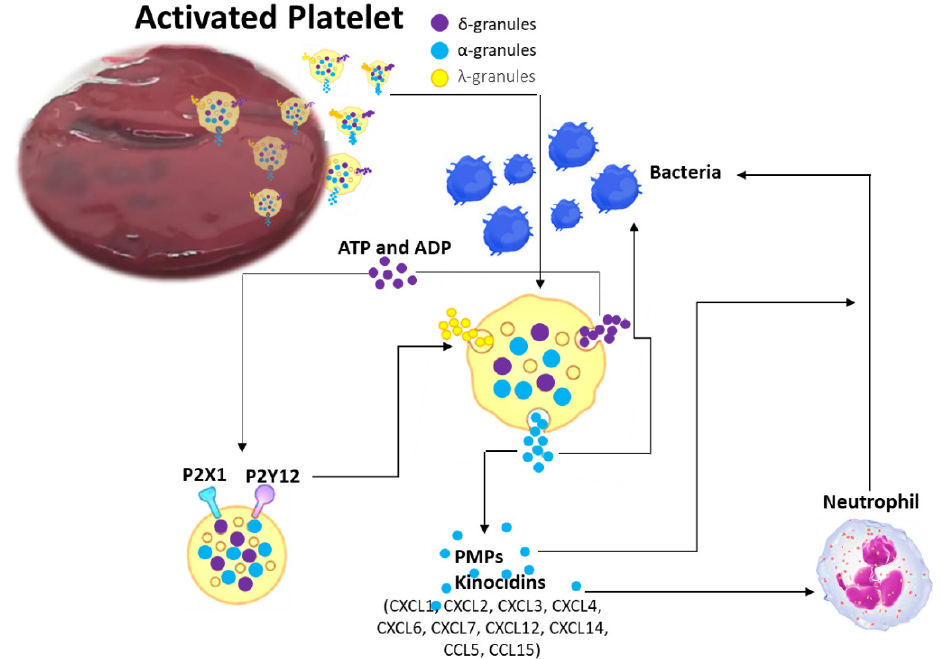
Figure 3. Schematic representation of potential antimicrobial activity of BM clot platelet. Adapted from Yeaman [38] by GIMP 2.10.32 software.